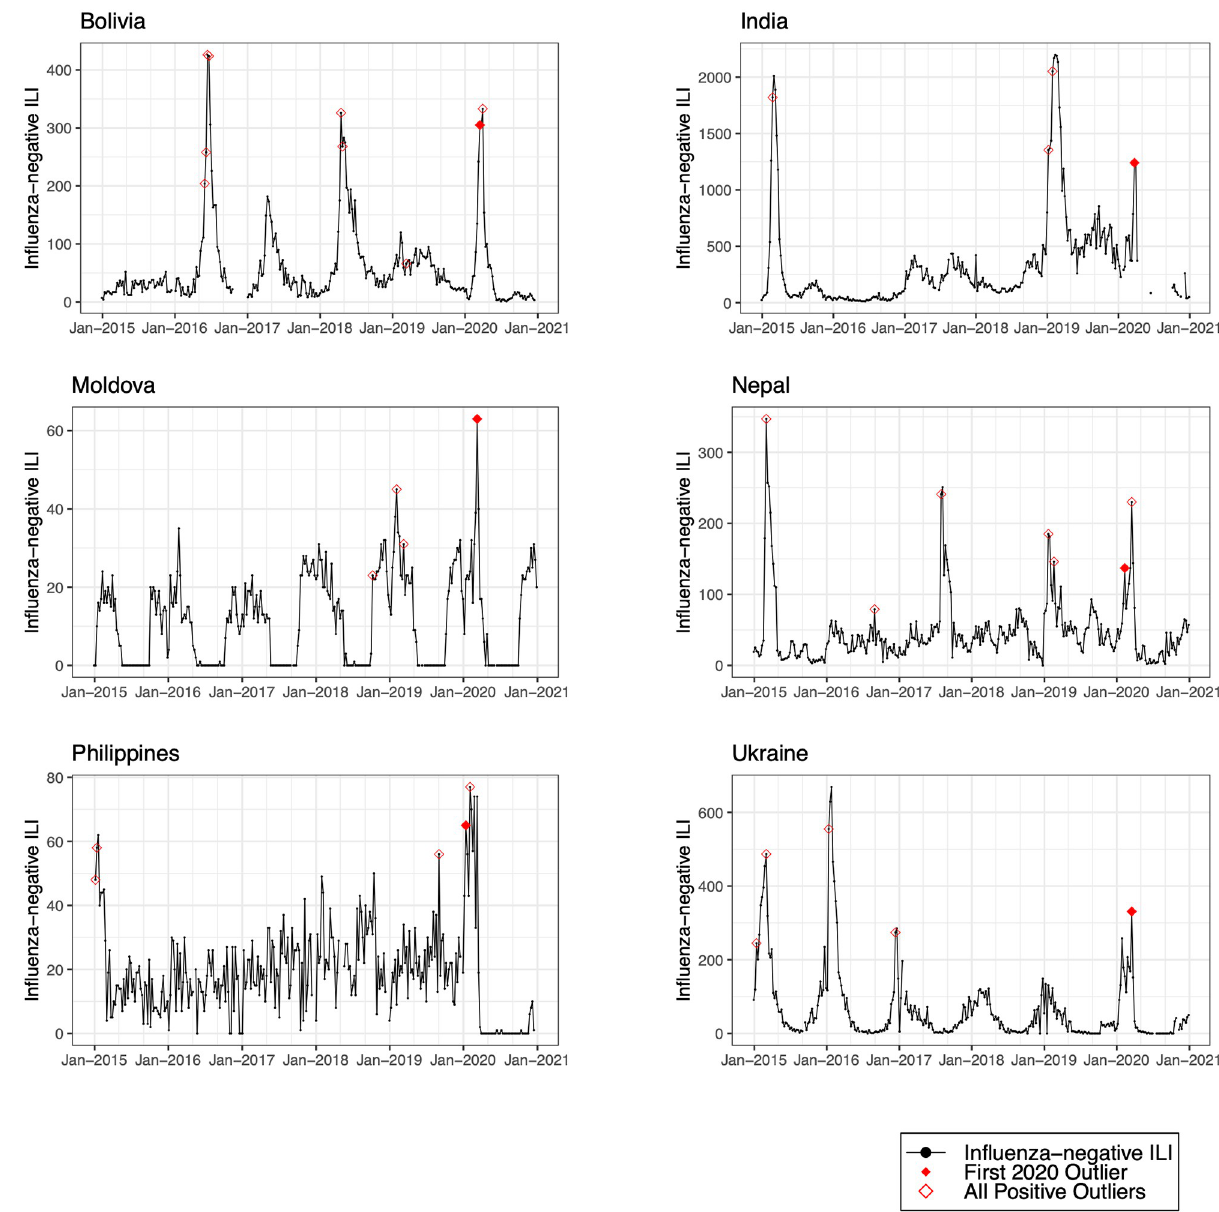
Fig 3. Observed trends in influenza-negative influenza-like illness (ILI) and detected outliers in lower-middle-income countries. Reported cases of influenza-negative ILI in each country between 2015 and 2020. Open red diamonds indicate all detected positive outliers, and filled red diamonds indicate the first outlier in